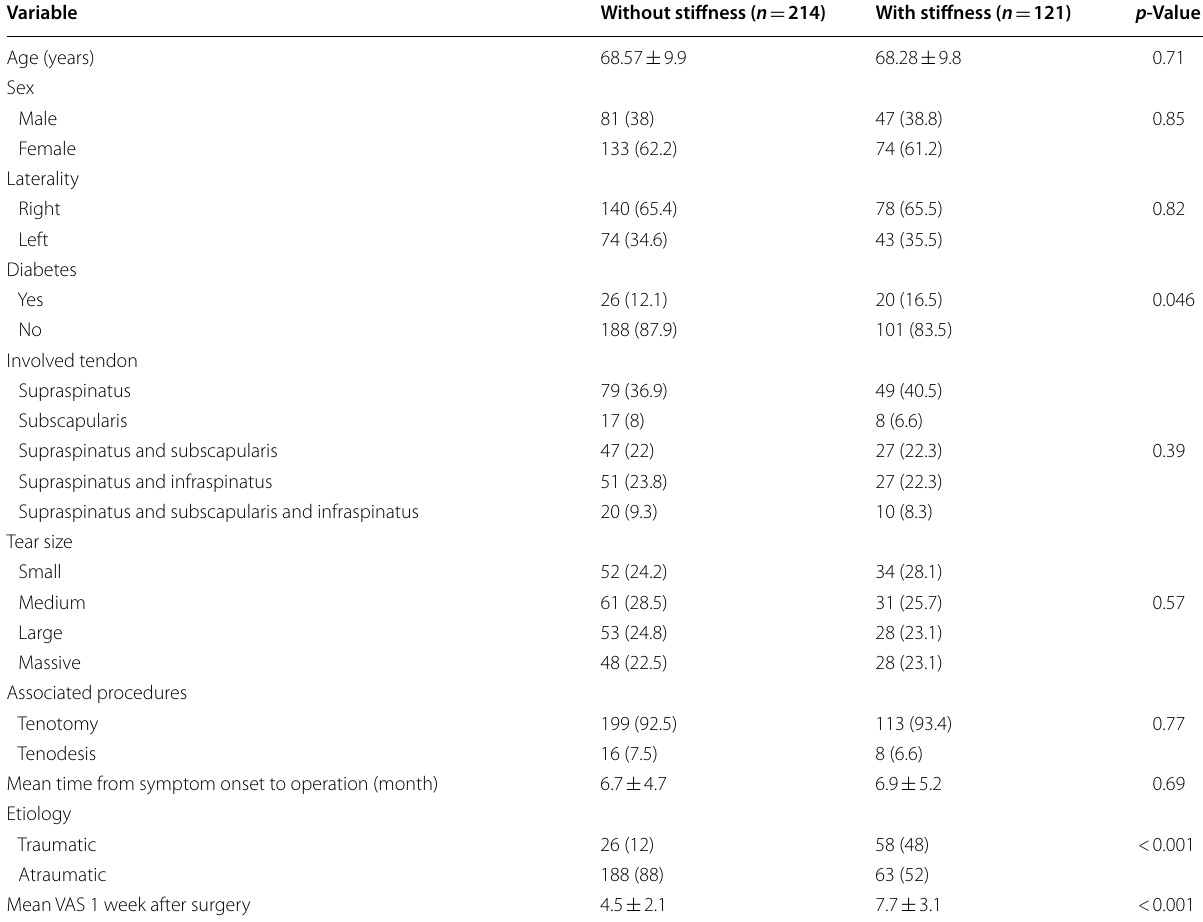
Data are shown as mean